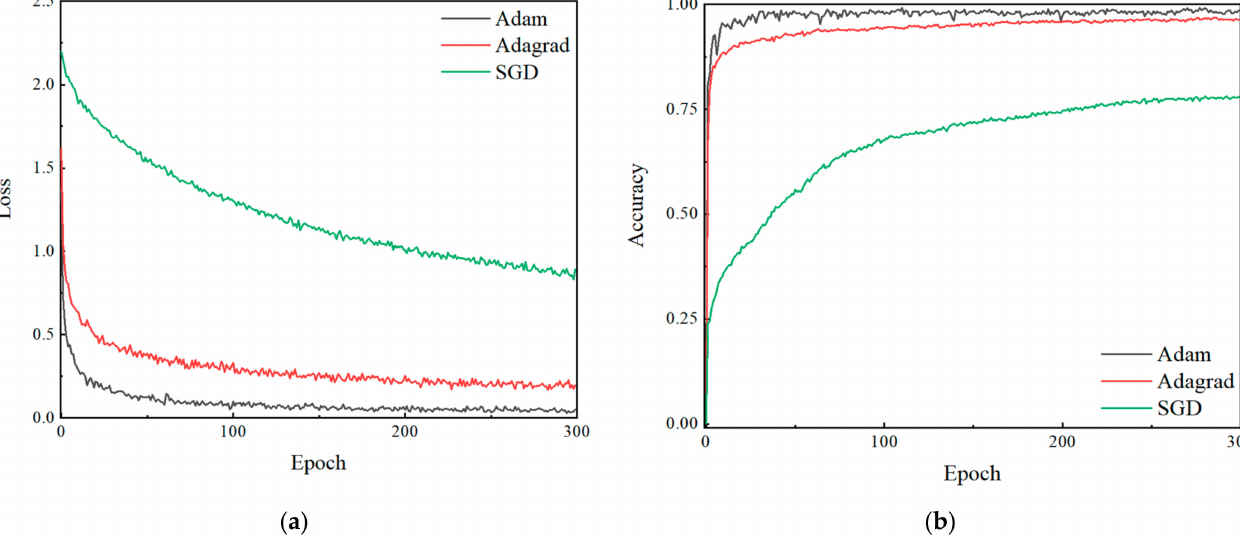
Figure 9. Comparison of the optimal algorithms: ( a ) Loss values; ( b ) Accuracy